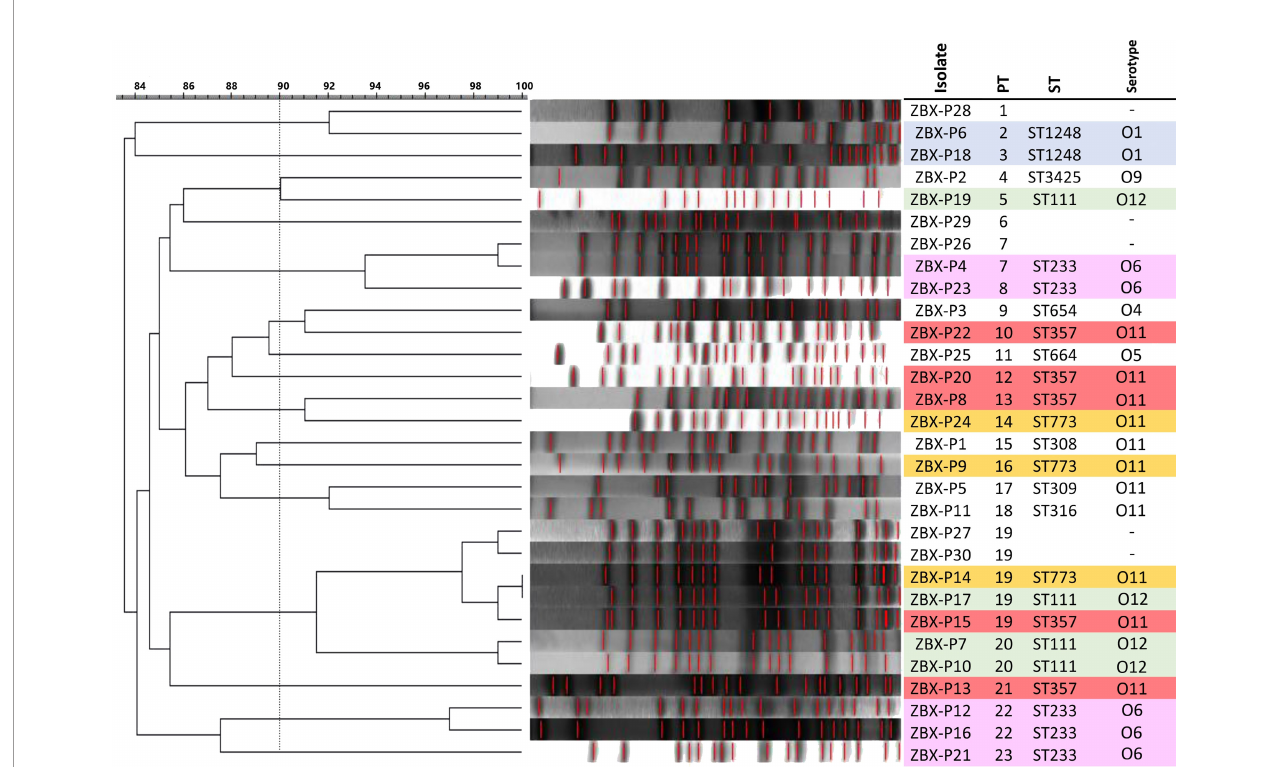
FIGURE 1 | b -lactamases and AmpC antibiotic resistance genes identi fi ed in the isolates. Isolate ’ s ST is also shown.